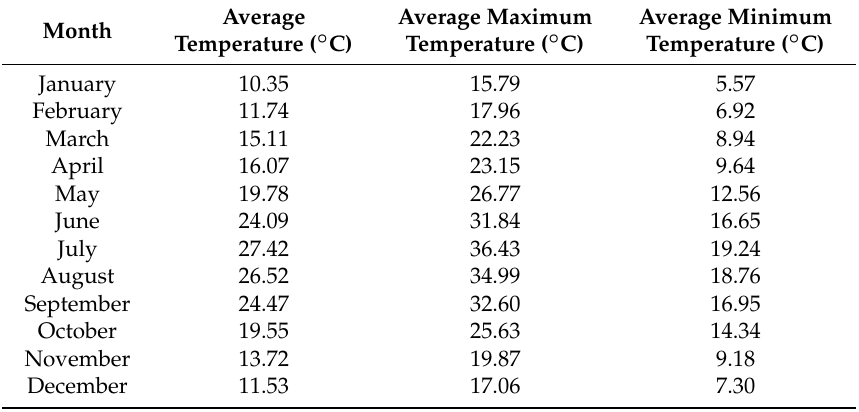
Table 2. Average temperatures in EnergyPlus Weather (EPW) file from the city of Seville.